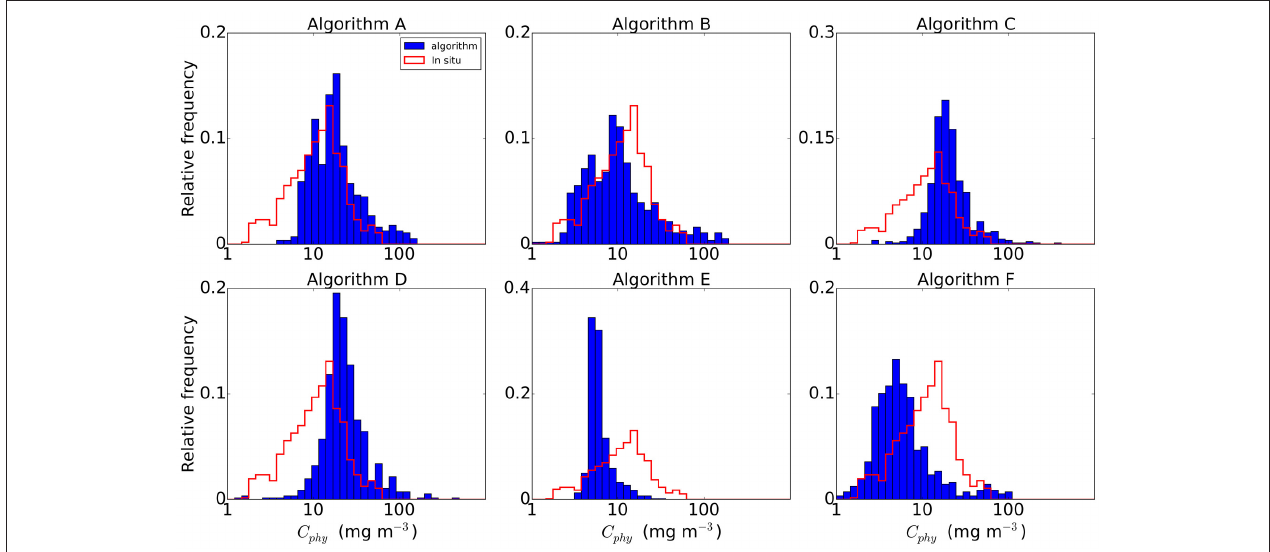
FIGURE 2 | Relative frequency distribution of C phy of the in situ data compared with the algorithms outputs. Note change in the scale of y-axis for Algorithms C and E.